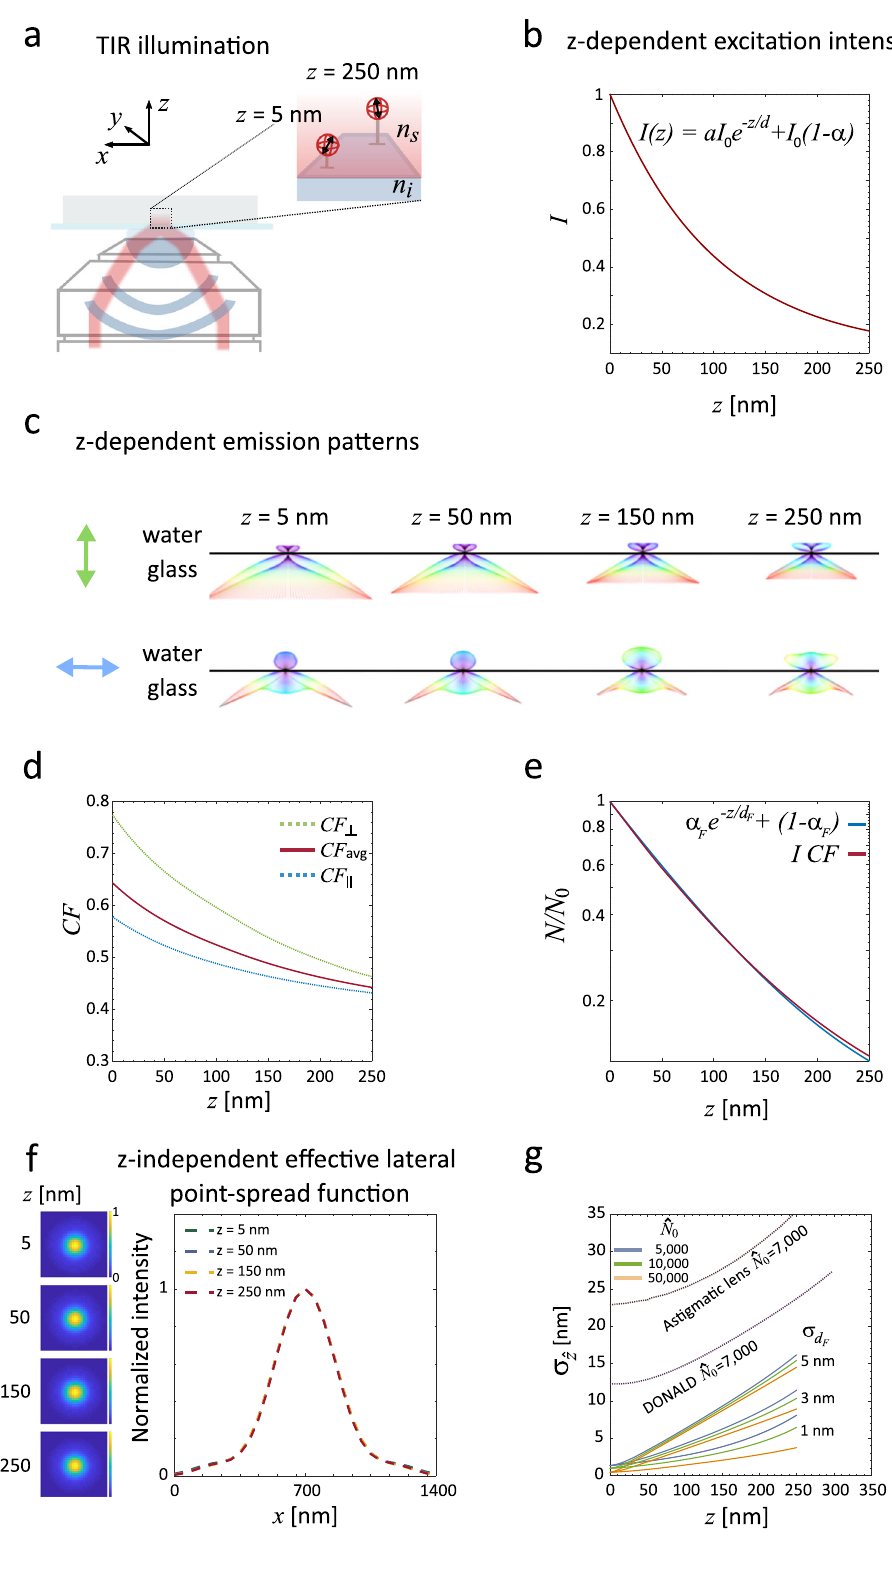
penetrating the medium of low refractive index with an intensity Figure 1 illustrates the concept of SIMPLER. Total internal that decays exponentially. In a fl uorescence microscope, TIR re fl ection occurs when light impinges from a medium with illumination can be generated by controlling the angle of refractive index n i on an interface with another medium of incidence of the excitation light using an immersion objective smaller refractive index n s < n i . If the angle of incidence θ i is ¼ arcsin n = n ð Þ , light is fully lens as schematically shown in Fig. 1a. In practice, the excitation larger than the critical angle θ C s i fi eld also contains a non-evanescent component due to re fl ected at the interface and an evanescent fi eld appears,